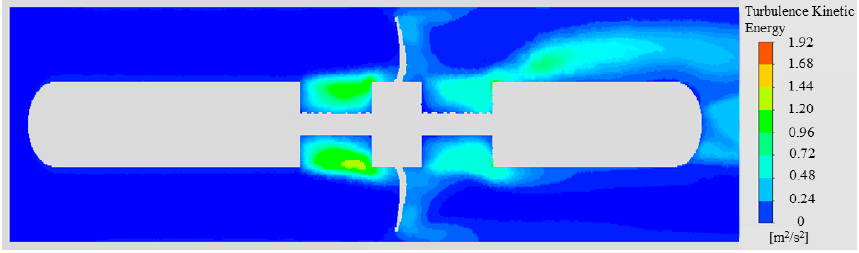
Figure 18. Cloud map of cross-section turbulence distribution (30 L/s).